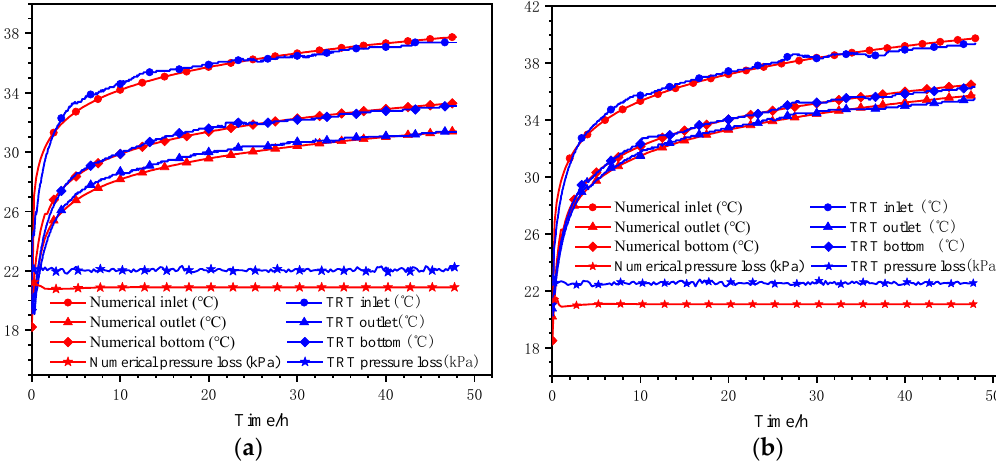
Figure 9. Comparison between TRT and simulation of B1 and B2. ( a ) Comparison between simulation and test results of B1. ( b ) Comparison between simulation and test results of B2.